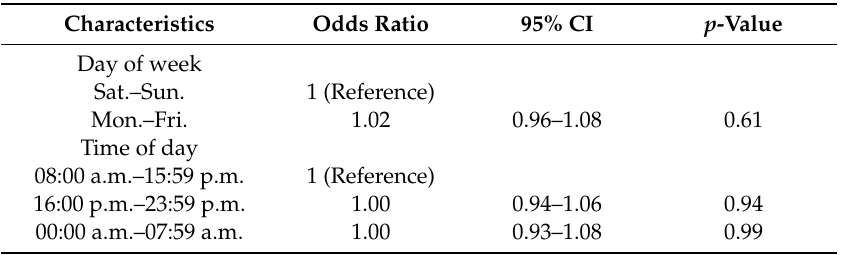
Table 4. Odds ratio for escorted transport to hospital, weekends vs. working days.